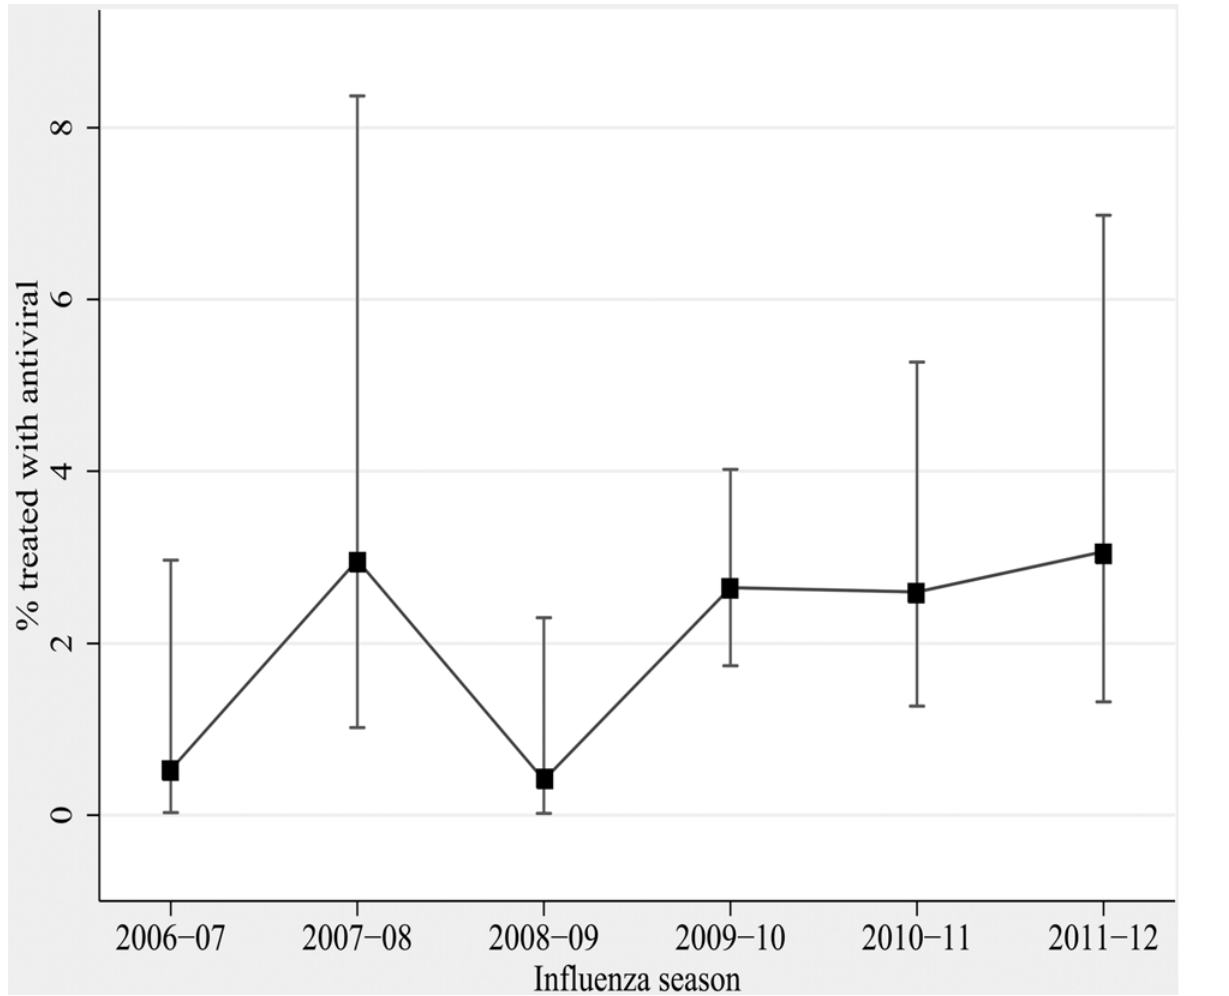
Fig 2. Antiviral treatment among adults (cid:1) 50 years of age hospitalized with acute respiratory illness, by season, 2006 – 2012.